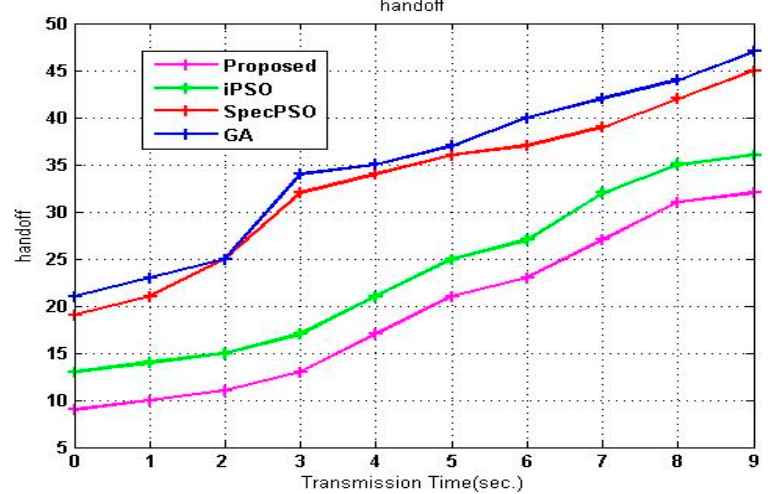
Figure 9. Handoff versus transmission time.